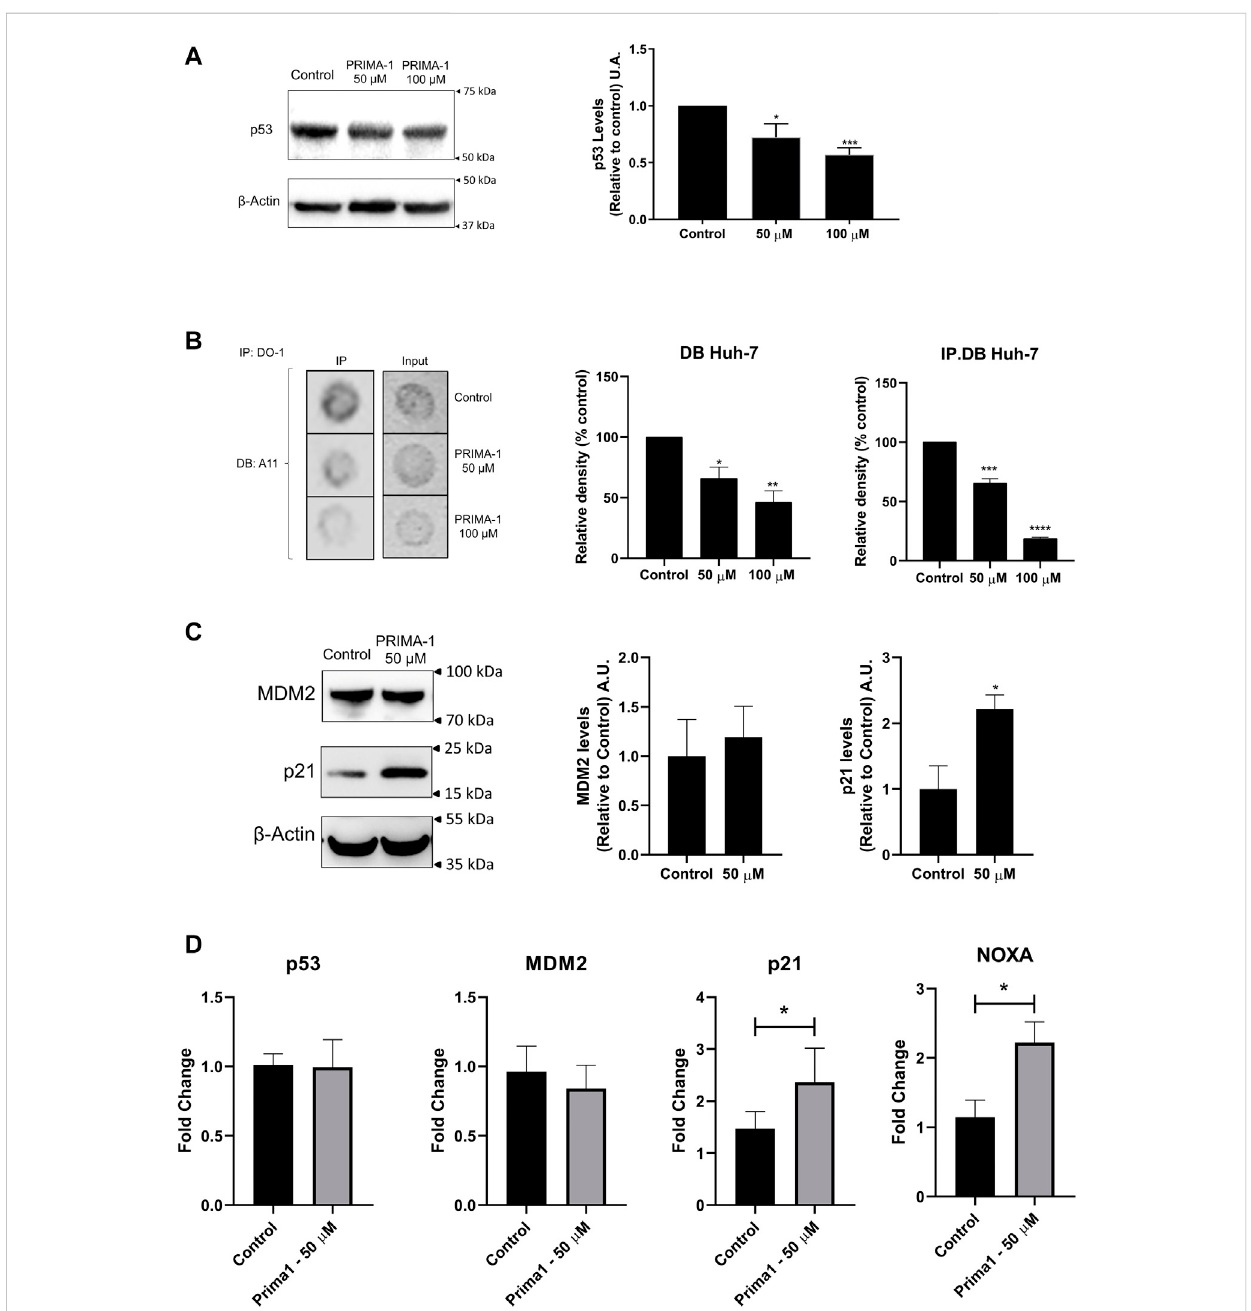
cells isenhancedfollowing treatment with PRIMA-1,while MDM2 levels arenot altered. (D) RT-qPCRof p53 target genes show no changes inMDM2 and TP53 gene expression, while CDKN1A (p21) and PMAIP1 (NOXA) are activated. Quanti fi cation of p53, p21, and MDM2 levels was relative to